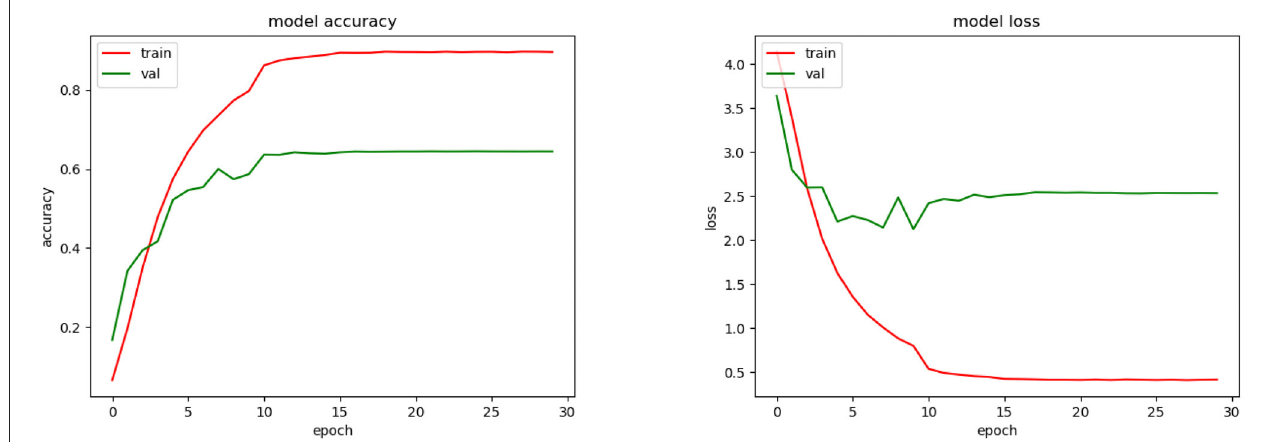
FIGURE 7 | Training accuracy and loss for CNN model.